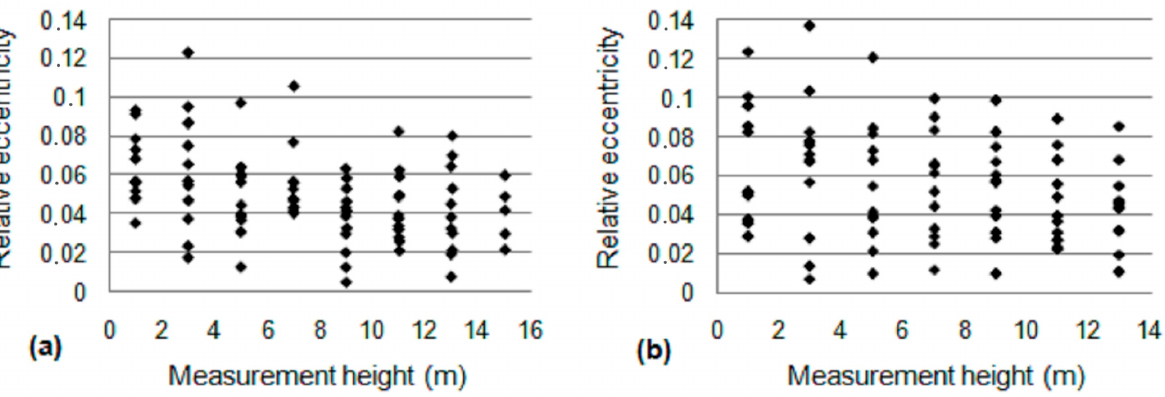
Figure 6. Distribution of eccentricity values in 3.5 m ( a ) and 2.5 m ( b ) variants. Table 6. Chi-square test results between the eccentricity direction (S-W, N-W) and height on the stem (value in bold denotes statistical significance).